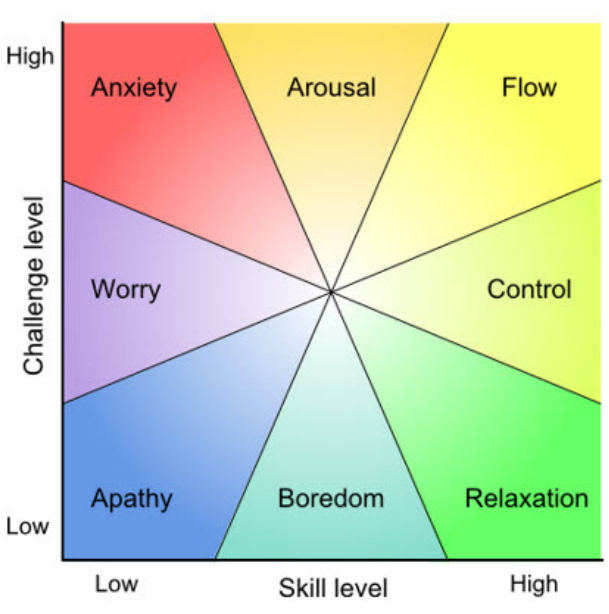
Figure 3. Csikszentmihalyi 's FLOW